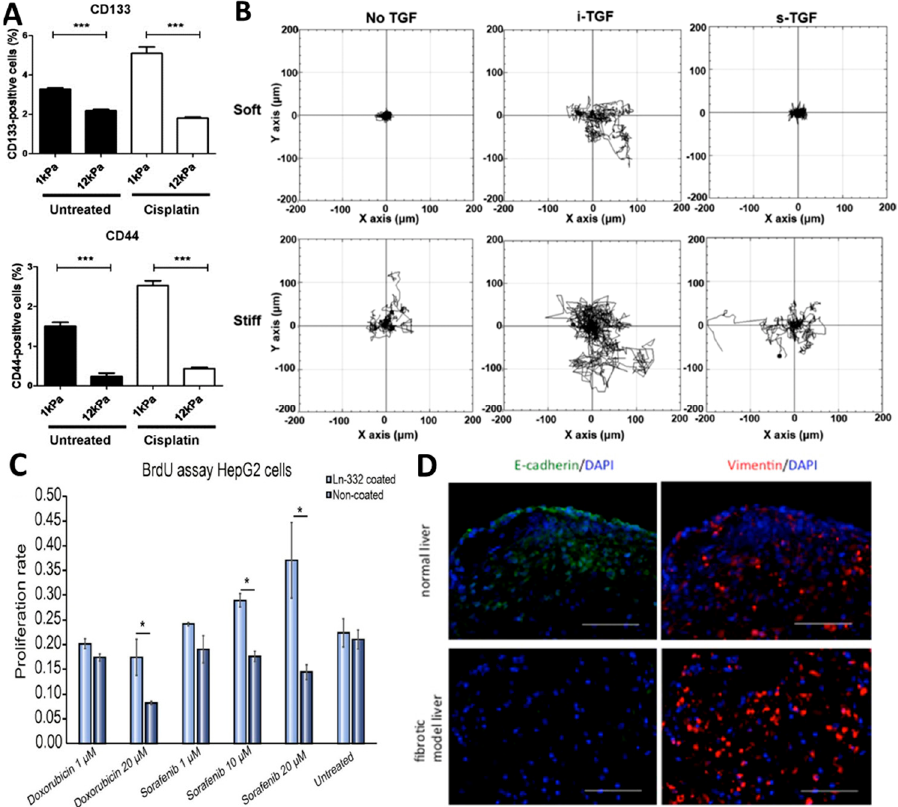
Figure 2. In vitro culture models to highlight the importance of the extracellular environment. ( A ) Flow cytometric analysis of cancer stem cell markers cluster of differentiation 133 (CD133) and cluster of differentiation 44 (CD44) in HepG2 cells cultured on soft or stiff matrices for five days shows effect of matrix and chemotherapy on stem cell marker expression. Adapted with permission [121]. Copyright 2019 American Chemical Society. ( B ) Representative trajectories of HCC cell migrations in different matrices. Adapted with permission [123]. ( C ) Proliferative capacity of coated and non-coated HepG2 cells after doxorubicin or sorafenib treatment for 48h ( n = 4). Laminin-322 (Ln-332) coating increased chemoresistance of HepG2 cells (scale bars: 100 μ m) Adapted with permission [100]. ( D ) Immunofluorescence staining showing the number of vimentin-positive cells is increased and E-cadherin-positive cells is decreased in a fibrotic liver sca ff old compared to normal liver, indicating the promotion of EMT phenotype. (scale bars: 100 µ m). Adapted with permission [129]. BrdU: 5- bromo-2’deoxyuridine; DAPI: 4 ′ ,6-diamidino-2-phenylindole; TGF: transforming growth factor. * p < 0.05; *** p < 0.001.